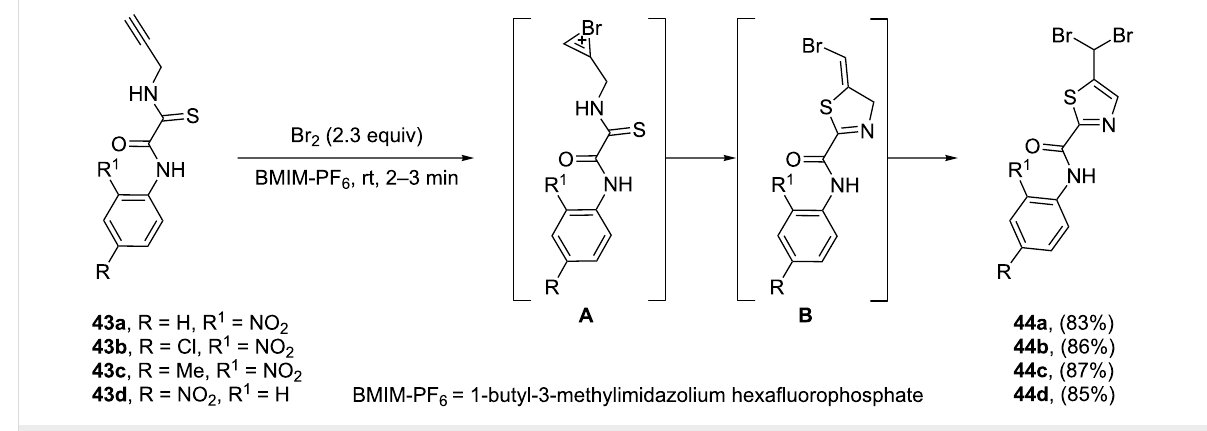
Scheme 11: Synthesis of 5-(dibromomethyl)thiazoles 44 via halocyclization of N -propargylamines 43 described by Yarovenko.